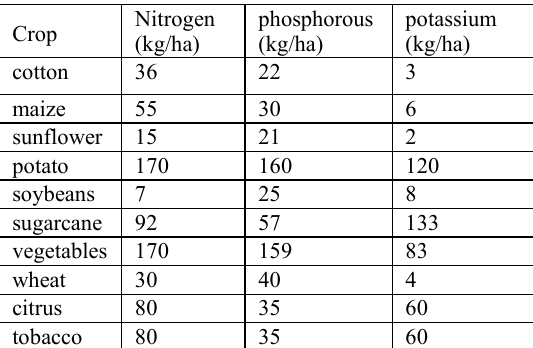
Table 3: showing fertilizer rate per crop for some crops in South Africa, in (kg/ha)